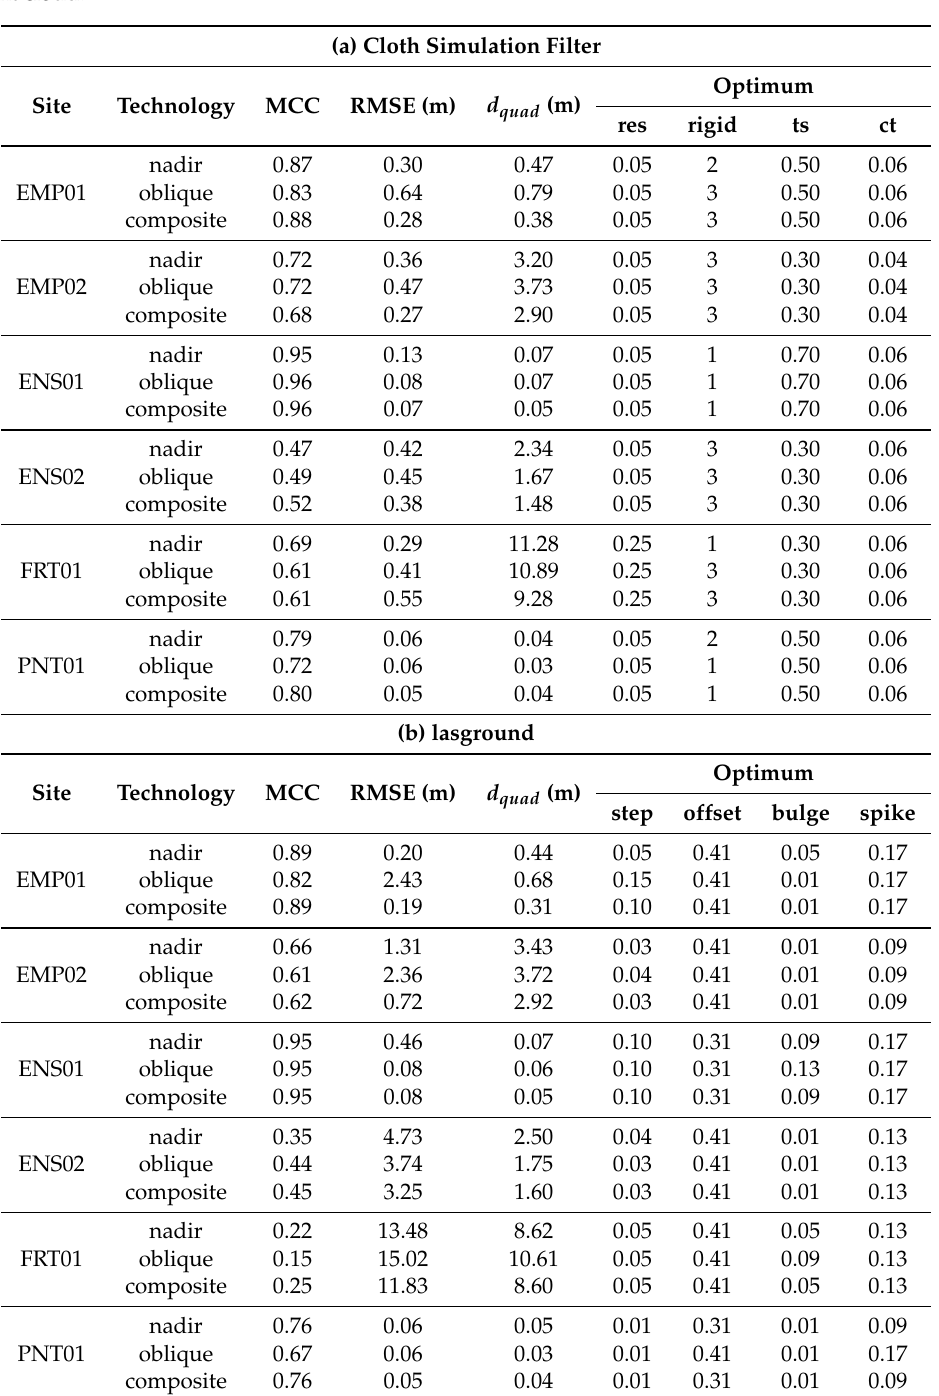
Table 5. The optimum settings of each point cloud examined in this study as determined based on Mathews Correlation Coefficient (MCC) compared to known ground points contained within each point